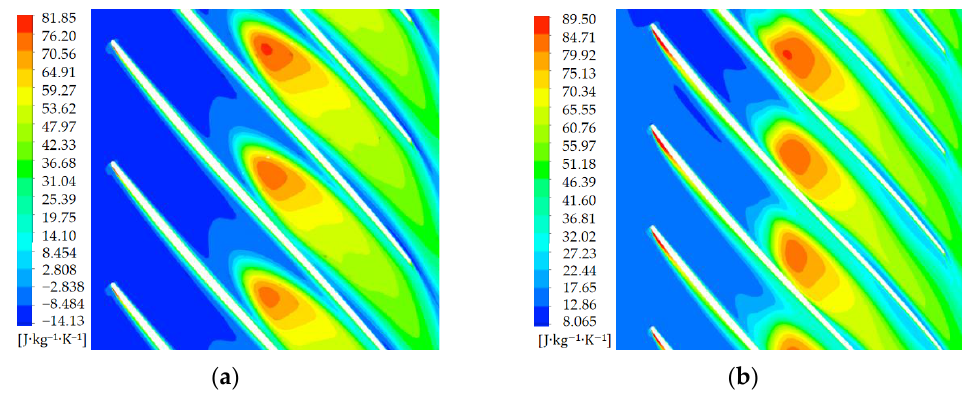
Figure 9. Static entropy contours of 90% heights of impellers. ( a ) First stage. ( b ) Second stage.